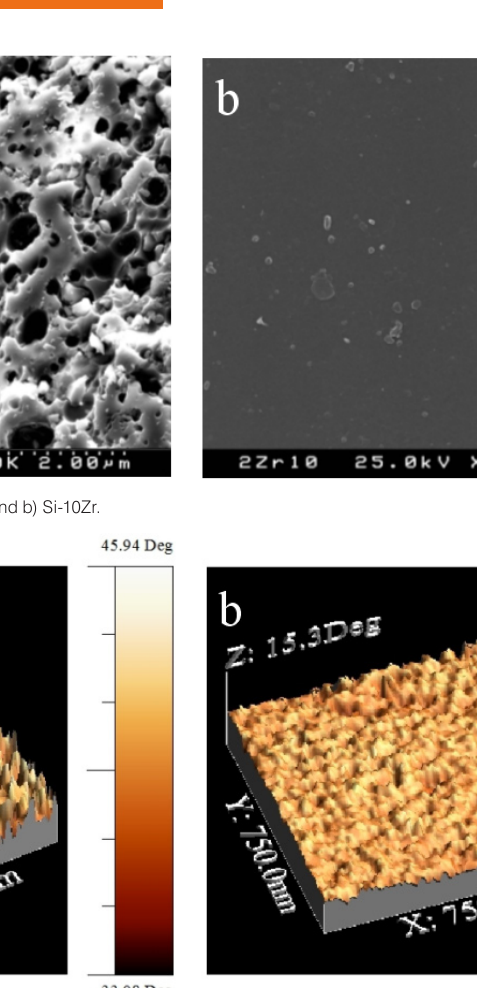
Figure 5. AFM images of a) Si-10B and b)